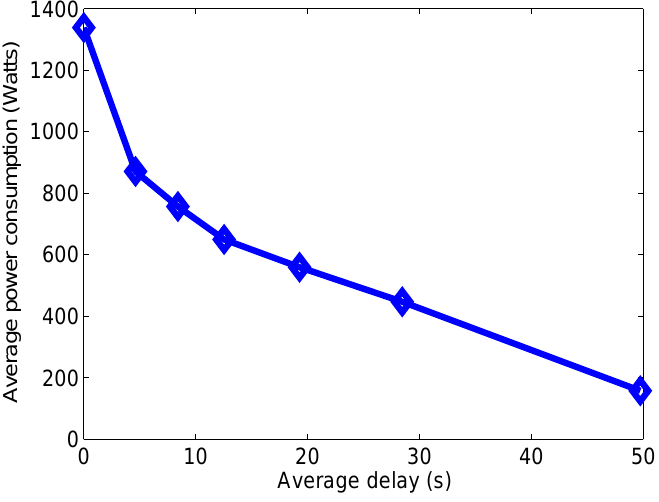
Figure 9. Observed relationship between average power consumption and average delay for different values of R on